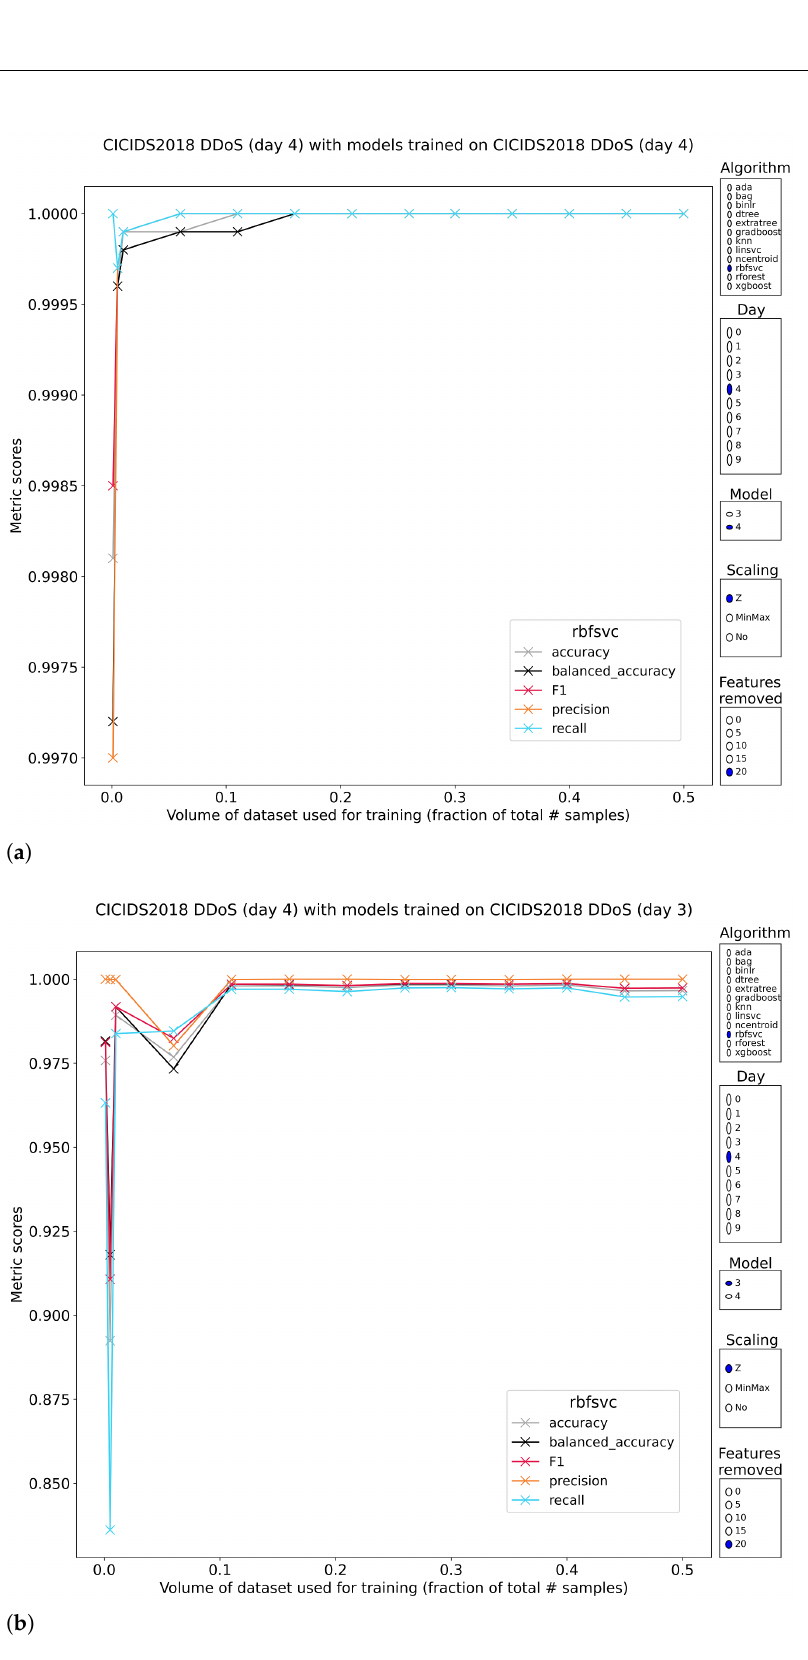
Figure 3. Performance comparison of the set of RBF-kernel SVMs, trained on the second subset of DDoS traffic in CSE-CIC-IDS2018, when evaluating its own test set ( a ) and the same set’s performance when evaluating the samples of the first DDoS subset of the same dataset ( b